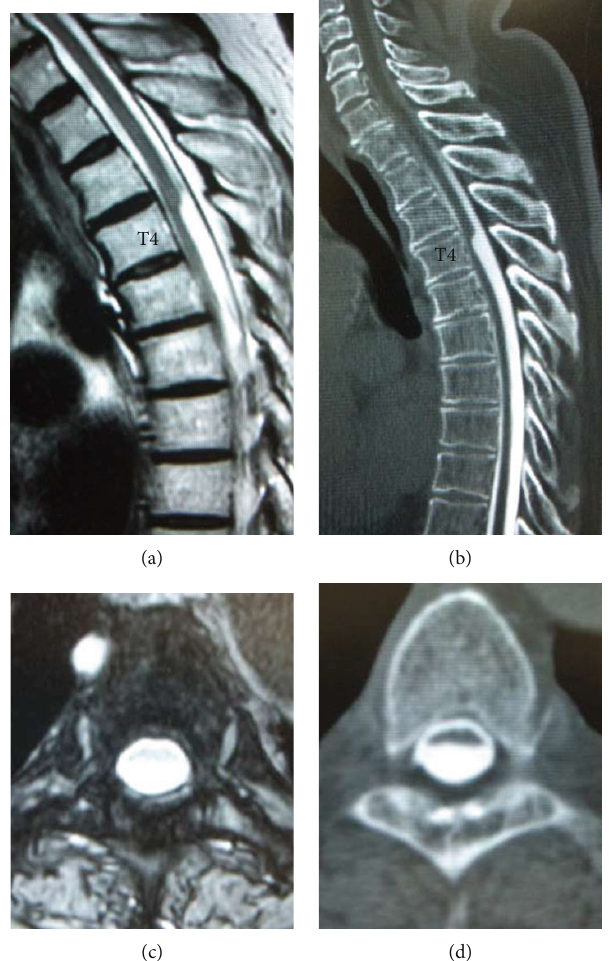
Figure 1: Sagittal MRI and CT myelography demonstrate a dorsal indentation, the so-called “ scalpel sign, ” at the T4